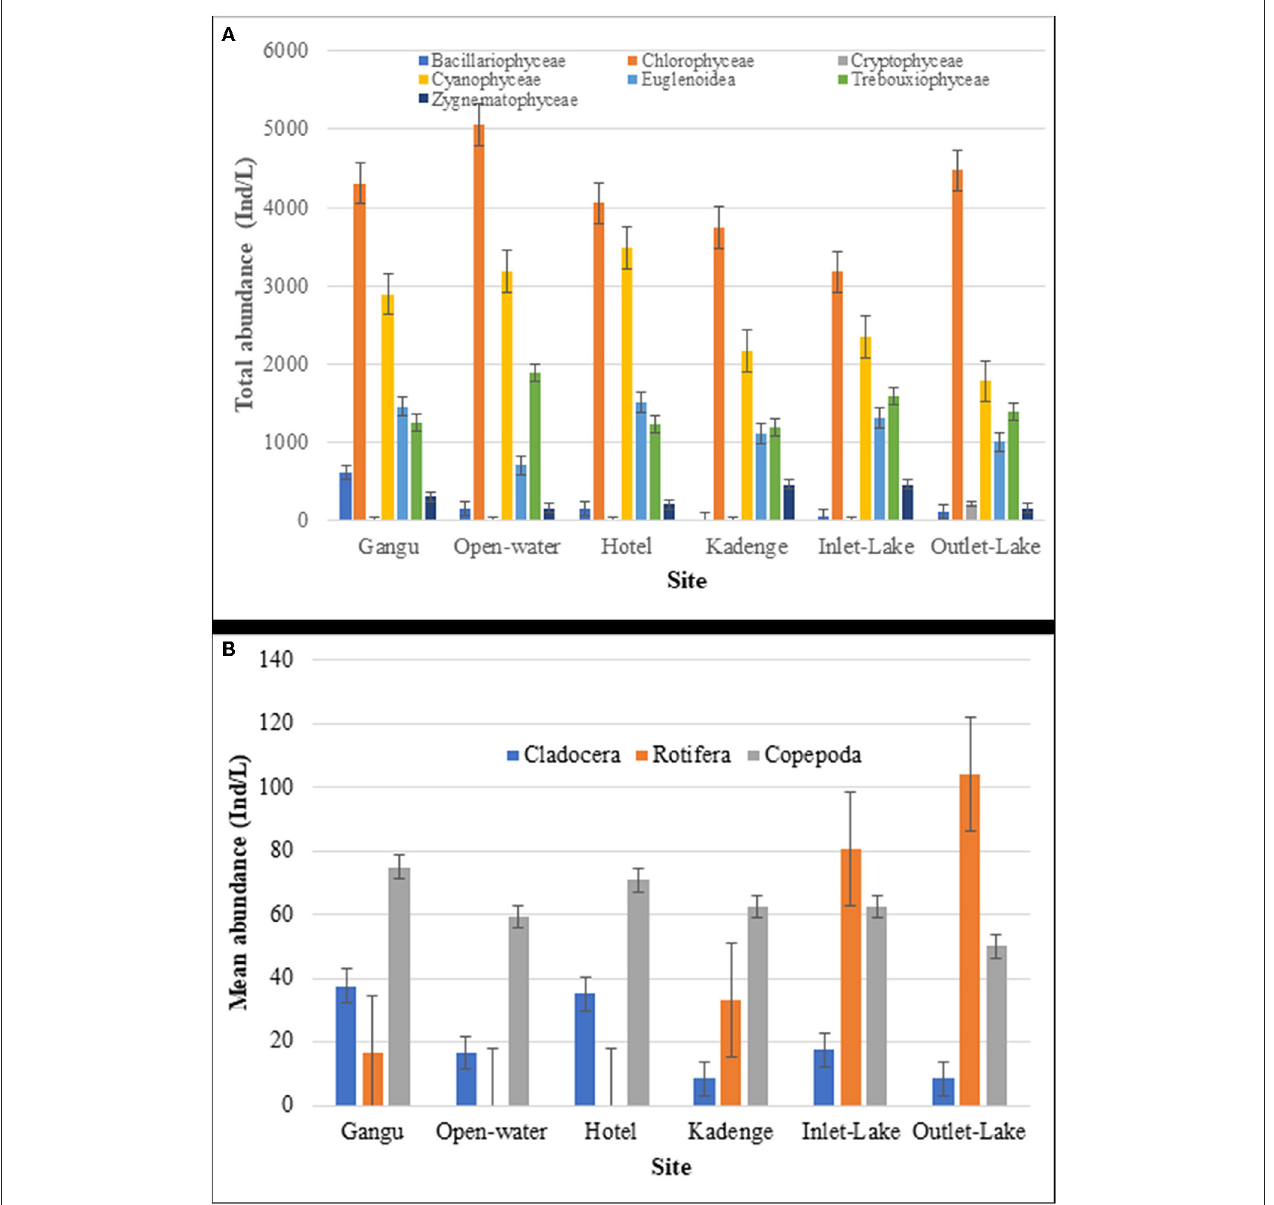
FIGURE 3 | Comparison of mean plankton abundance at different sampling stations in Lake Kanyaboli from February 2020 to February 2021 [ (A) : phytoplankton; (B) : zooplankton].